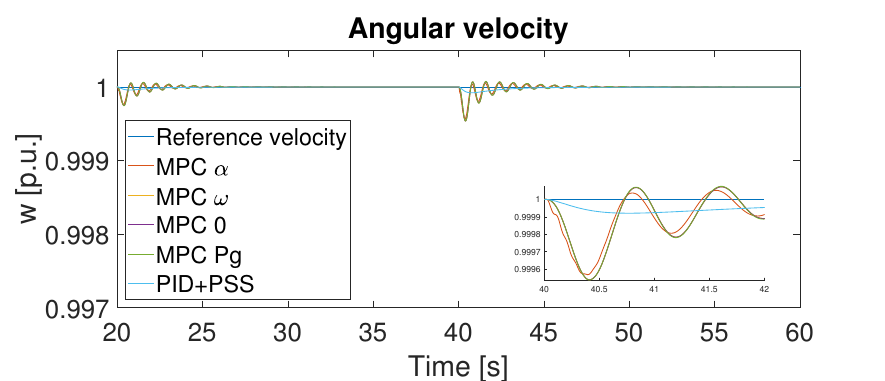
Figure 12. Generator voltage (set active power step).